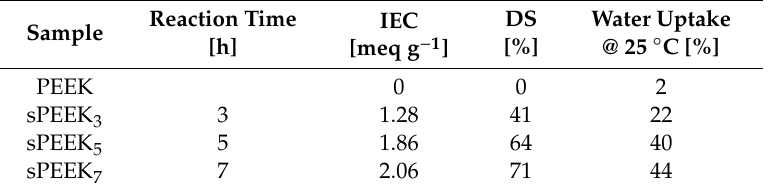
Table1. IonExchangeCapacity(IEC),sulfonationdegree(DS)andwateruptakeofthecorrespondingmembranes.